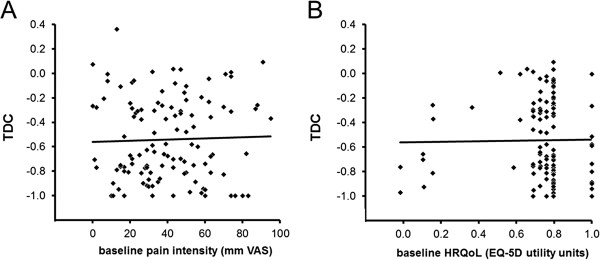
Relationships between TDC-values and baseline values of intensity of predominant pain from the masticatory system (A) and general Health-related Quality of Life (B). These baseline values are related to the severity of myogenous Temporomandibular Disorders in individual patients; the values of HRQoL in an inversely way. The TDC-values are from the last evaluation visit at LM (last measurement) following treatment and include possibly a separate addition of reference items by clinician and investigator (based on data from assessor) and considering only the added items from the assessor. For TDC = 0, an overall change in signs and symptoms is lacking following treatment and for TDC = −1 all signs and symptoms of myogenous TMD have disappeared. Solid lines, regression lines: TDC = 0.00047.PI – 0.560, in which PI is pain intensity (Pearson’s correlation coefficient: r = 0.031, not significant, n = 118), and TDC = 0.0245.HRQoL-0.564, in which HRQoL is Health-related Quality of Life (r = 0.015, not significant, n = 112, 6 missing values). Similarly, no significant relationships were observed for TDC from the end measurement (EM) following treatment in the short-term and for other modes of addition of items, including no-addition. Note that significant regressions are lacking while the scatter in TDC-values is similar within the range of baseline values, indicating that (i) the TDC-values from individual patients are independent from their baseline values of pain intensity or HRQoL, and (ii) a similar variety of relative change following treatment occurs for the various patients, regardless of the baseline severity of myogenous TMD. The fraction of patients whose TDC-value has dropped to or beyond the cut-off level of −0.379 and thus the chance of attaining functional status, is independent from the patient’s baseline severity level.